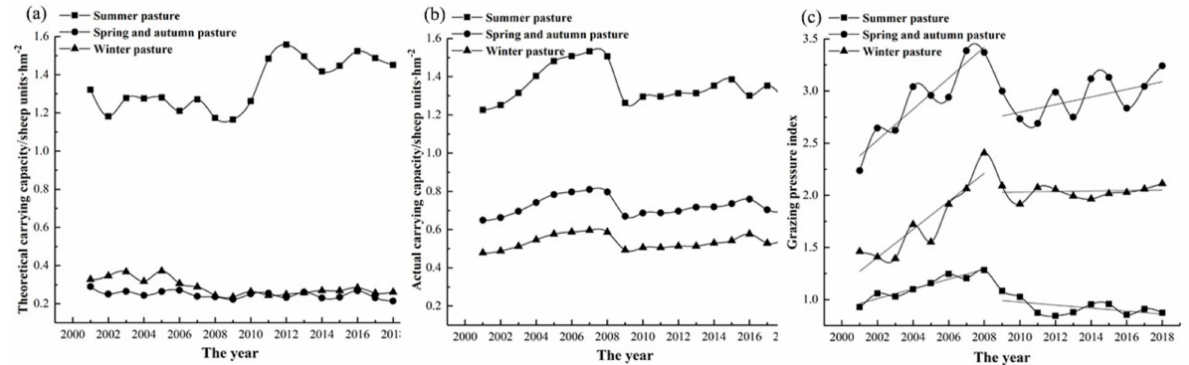
Figure 12. Changes in theoretical carrying capacity ( a ), actual carrying capacity ( b ), and grazing pressure index ( c ) in Fuyun County from 2001 to